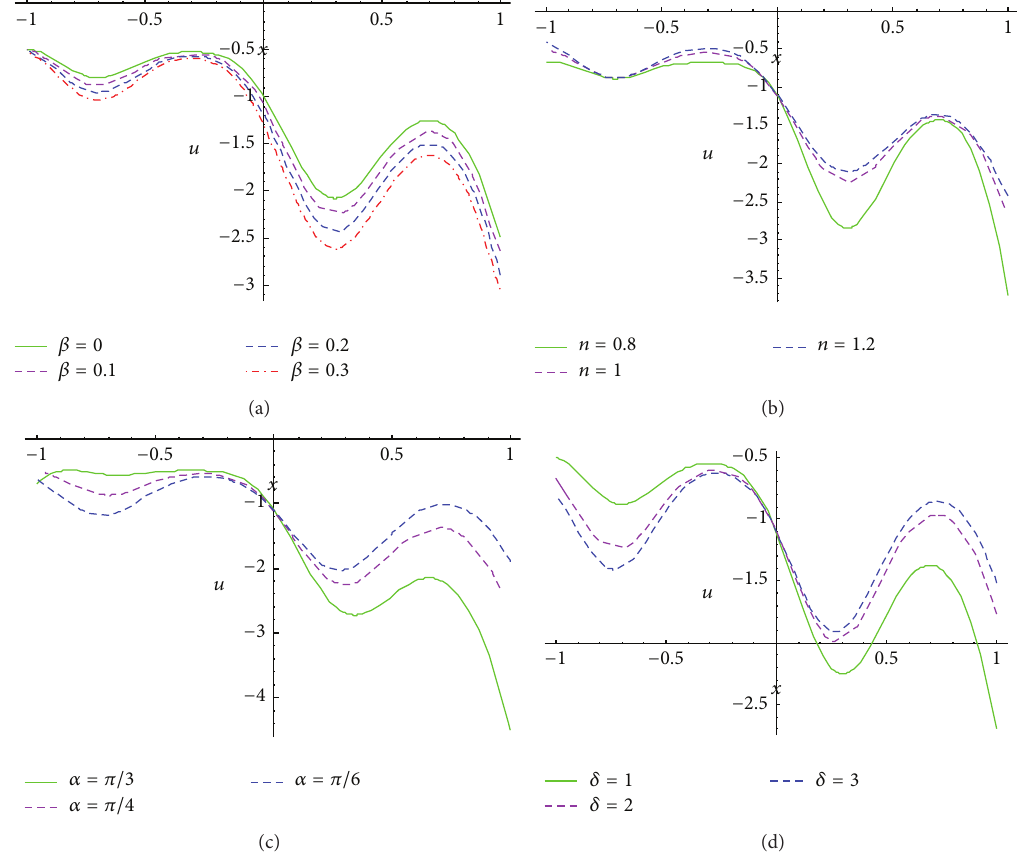
Figure 3: Axial velocity versus axial displacement at 𝜙 = 0 . 5, 𝜕𝑝/𝜕𝑥 = 1, 𝑦 = 1 for (a) 𝑛 = 1, 𝛼 = 𝜋/ 4, 𝛿 = 1, and various values of slip parameter 𝛽 = 0 , 0 . 1 , 0 . 2 , 0 . 3, (b) 𝛽 = 0 . 1, 𝛼 = 𝜋/ 4, 𝛿 = 1, and various values of fluid behavior index 𝑛 = 0 . 8 , 1 , 1 . 2, (c) 𝛽 = 0 . 1, 𝑛 = 1, 𝛿 = 1, and various values of inclination of channel 𝛼 = 𝜋/ 3 , 𝜋/ 4 , 𝜋/ 6, and (d) 𝛽 = 0 . 1, 𝑛 = 1, 𝛼 = 𝜋/ 4, and various values of wave number 𝛿 = 1 , 2 ,